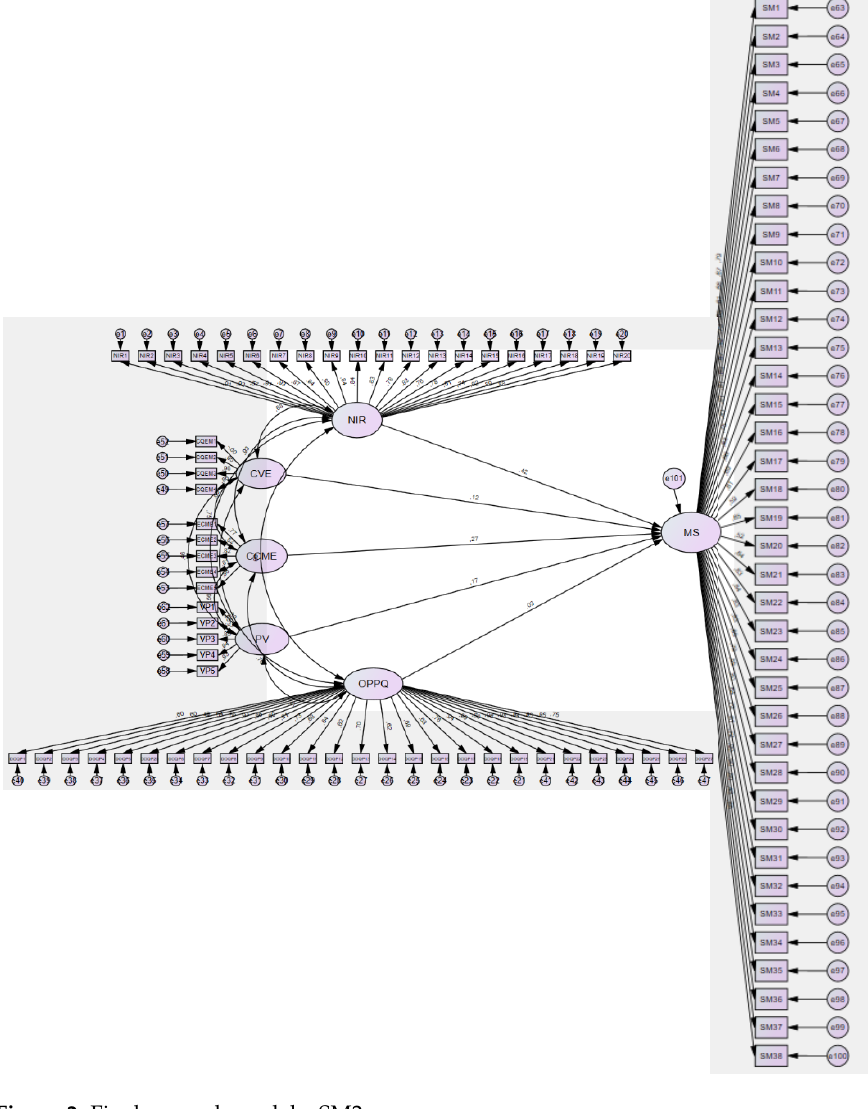
Figure 2. Final research model—SM2.